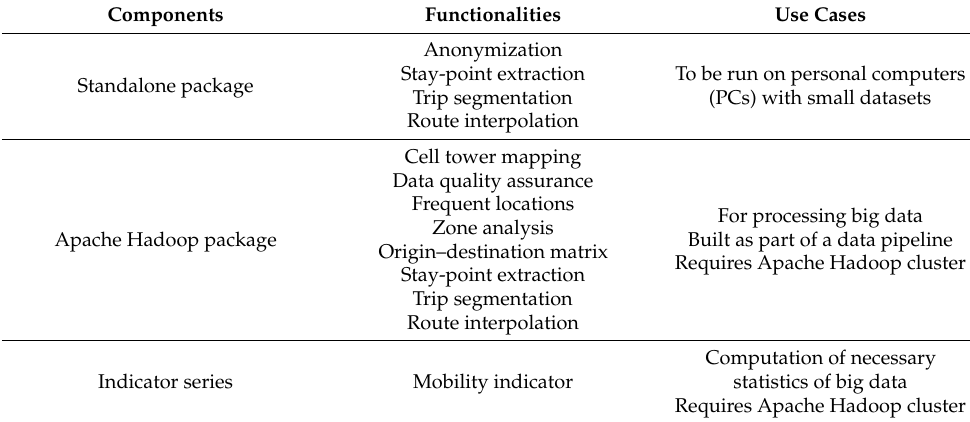
Table 2. The three main components of Mobipack 1